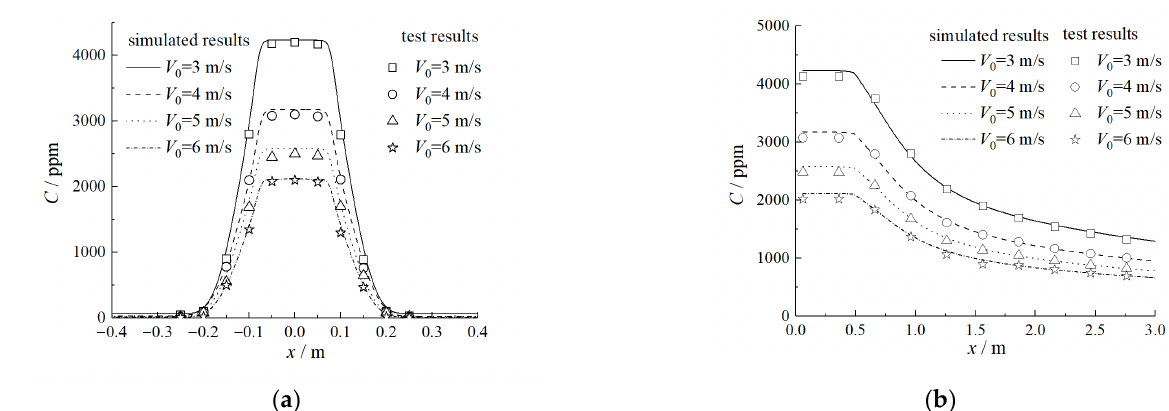
Figure 7. Comparison between the results of numerical simulation and experimental model: ( a ) vertical discharge pattern; ( b ) horizontal discharge pattern.